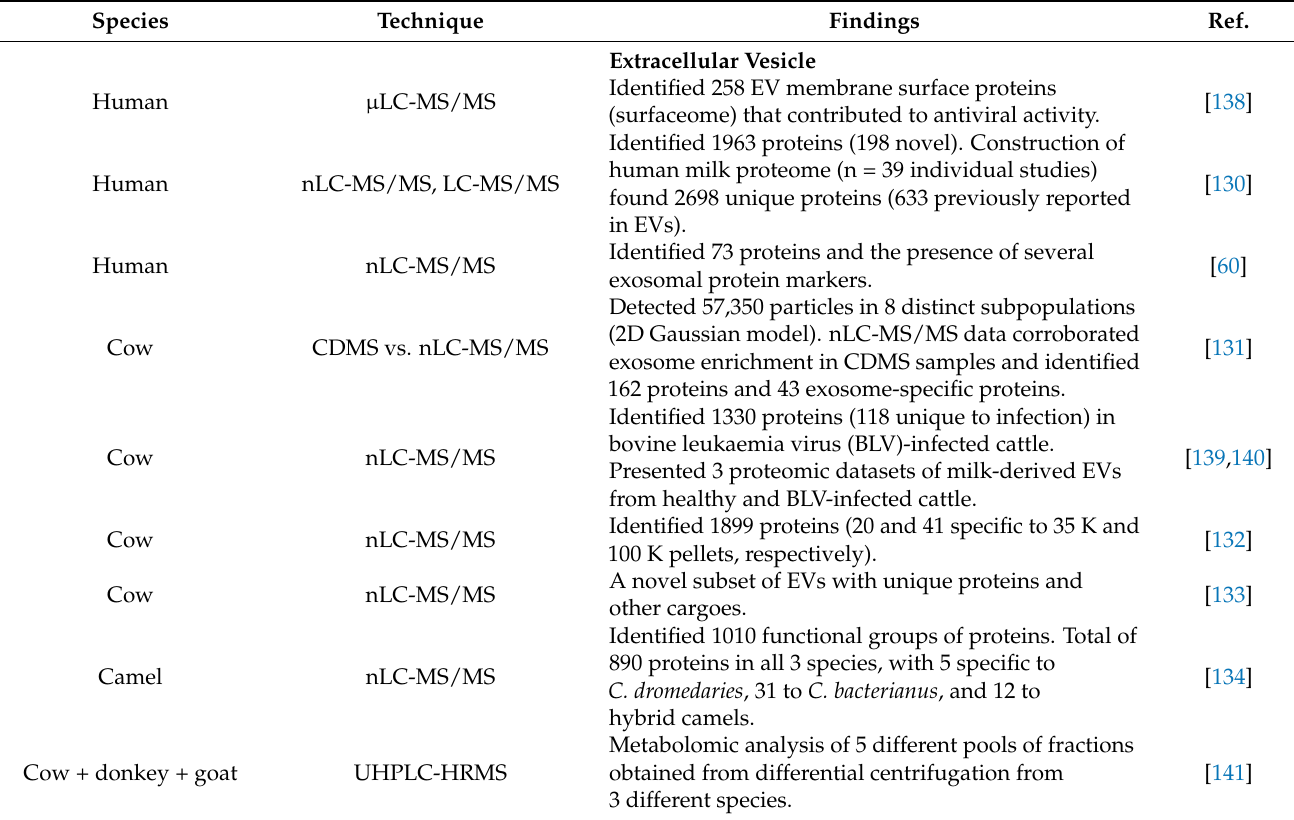
Table 4. Major findings of analytical techniques used to characterise the protein composition of milk-derived EVs and exosomes.